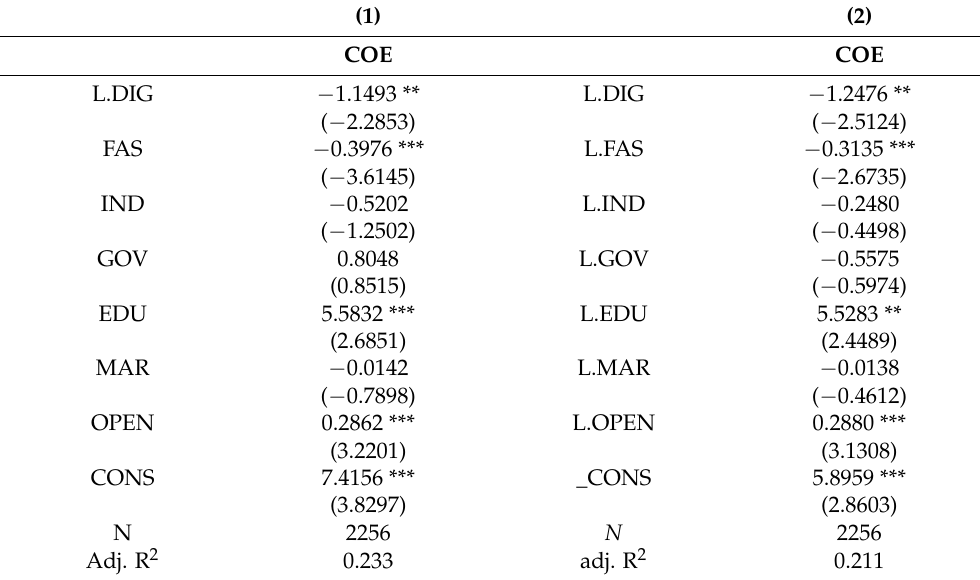
Table 4. Endogenous test.